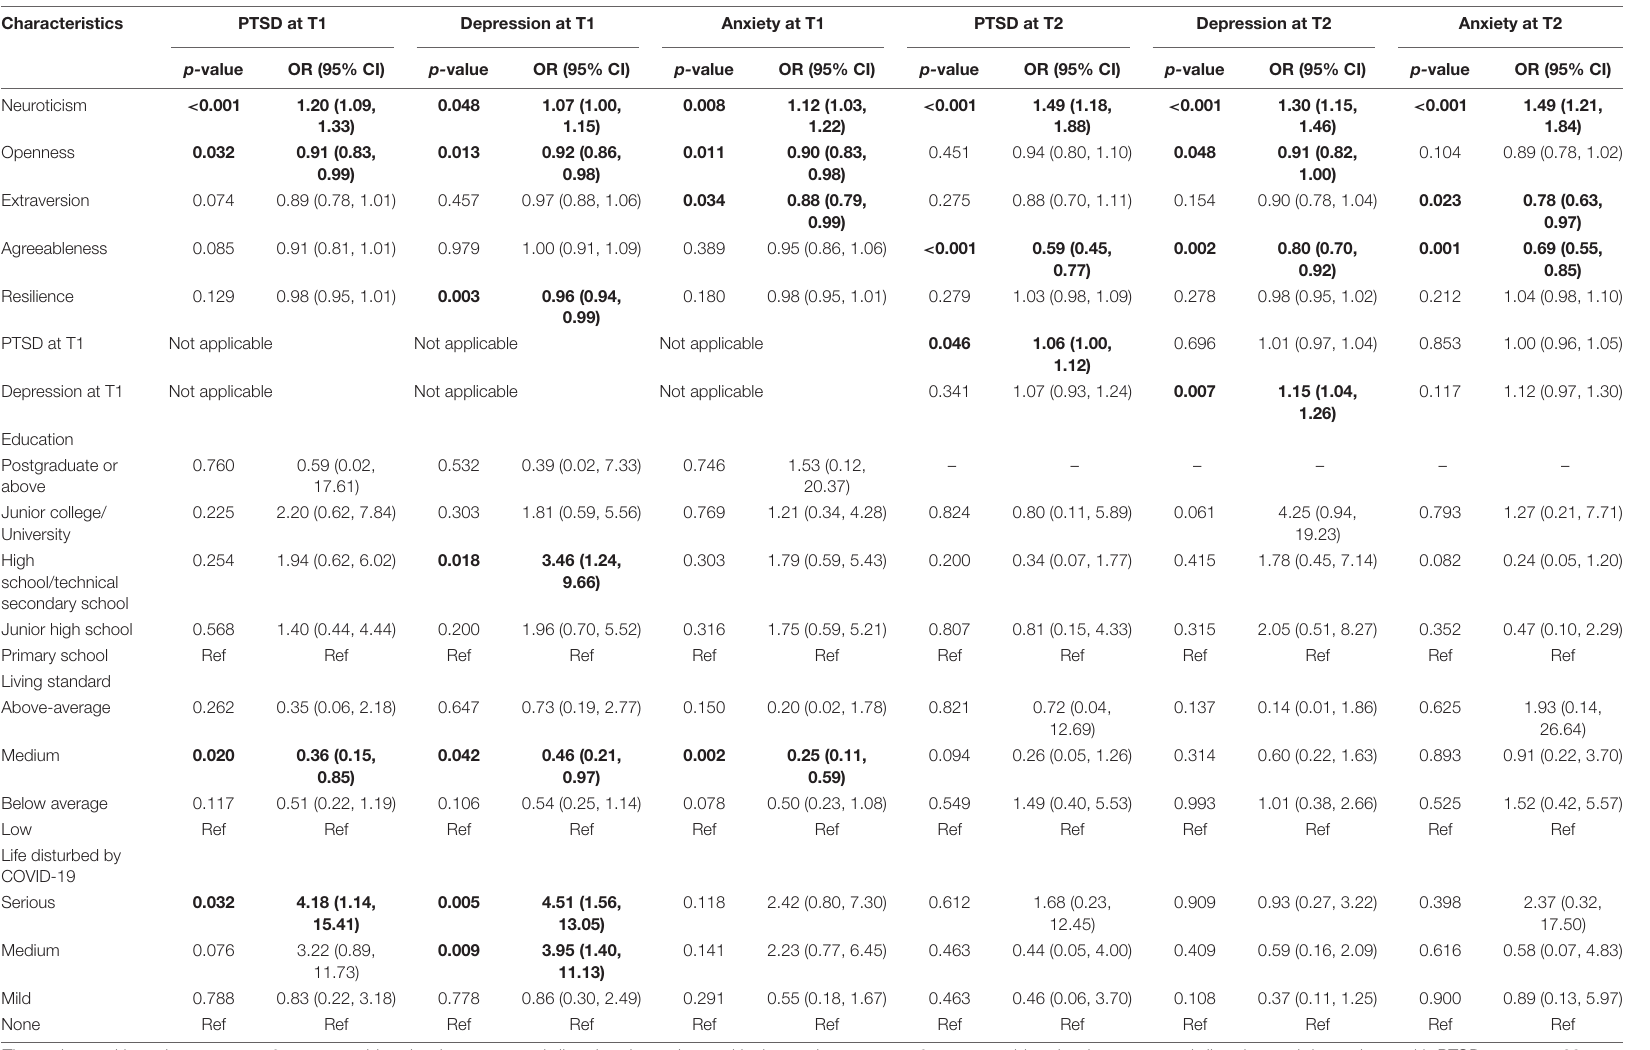
The patients with anxiety scores > 9 were considered to have a mental disorder; the patients with depression scores > 9 were considered to have a mental disorder; and the patients with PTSD scores > 33 were considered to have a mental disorder. Bold indicates p < 0.05. All the predictors were included in the multivariate logistic regressions (these three predictors, PTSD at T1, depression at T1, and anxiety at T1, were only included in the models of PTSD at T2, depression at T2, and anxiety at T2); for brevity, only predictors with significant effects are presented. OR, odds ratio; Ref, reference; CI, confidence interval; PTSD, posttraumatic stress disorder; T1, the first survey time point; T2, the second survey time point. Variables measured twice are marked with T1 and T2 to distinguish the time, e.g., PTSD at T2 was PTSD measured at T2; reference category—no PTSD symptoms for the PTSD model, no depression symptoms for the depression model, and no anxiety symptoms for the anxiety